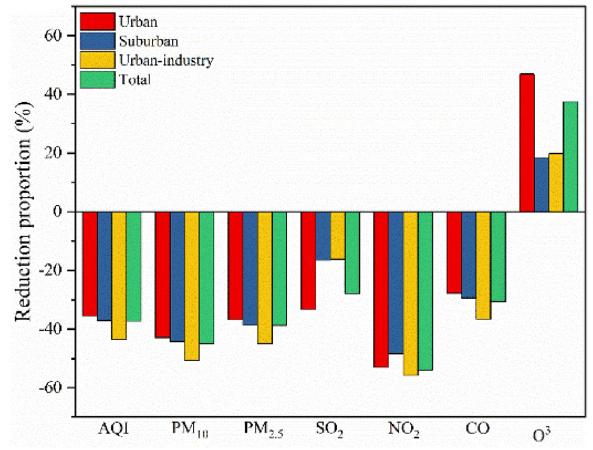
Figure 4. General reductions in the concentrations of major air